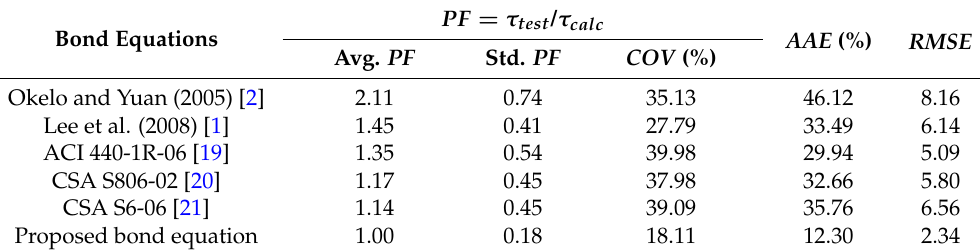
Table 4. Comparison of bond equations for the second group.